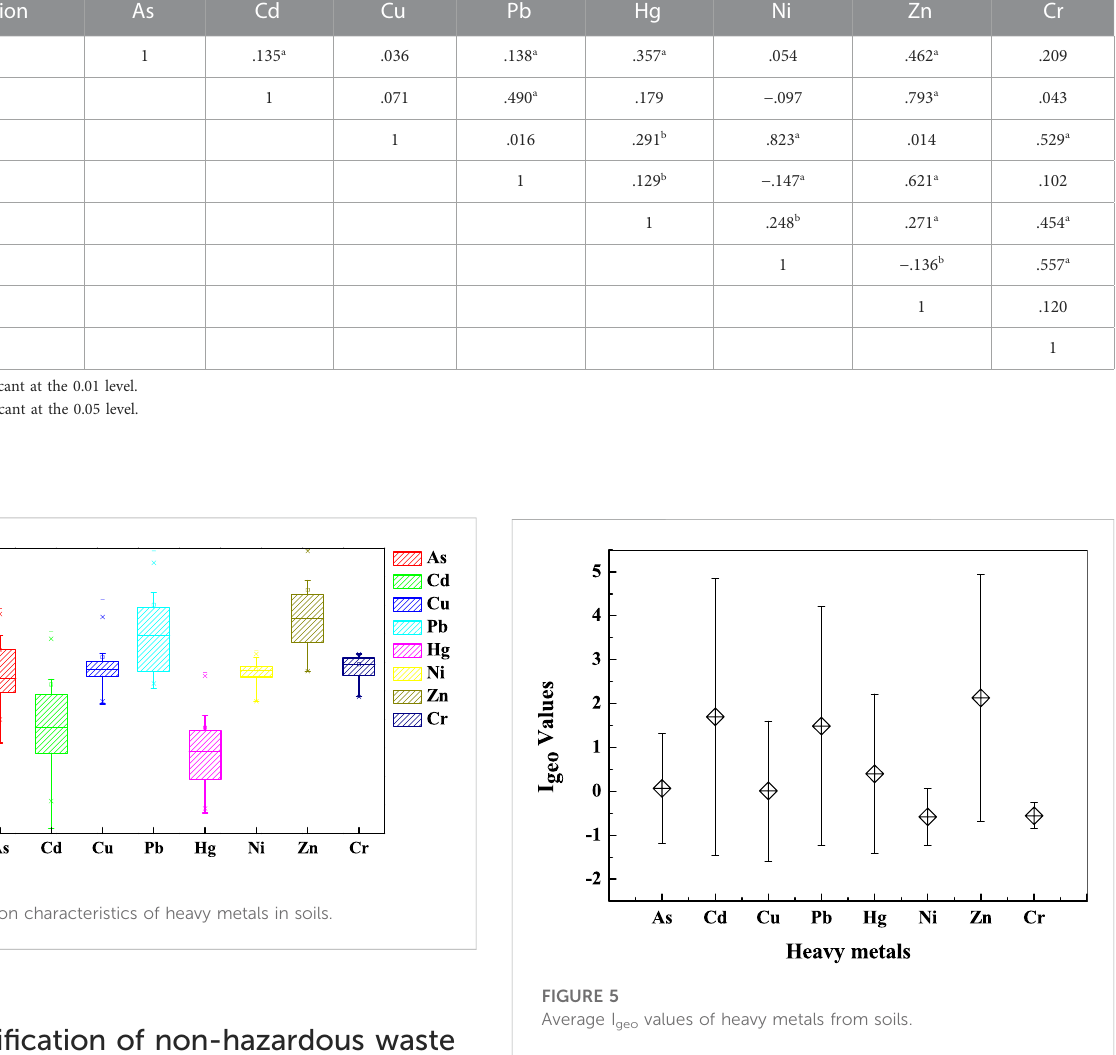
TABLE 2 Pearson correlations of different heavy metals in soils. Correlation